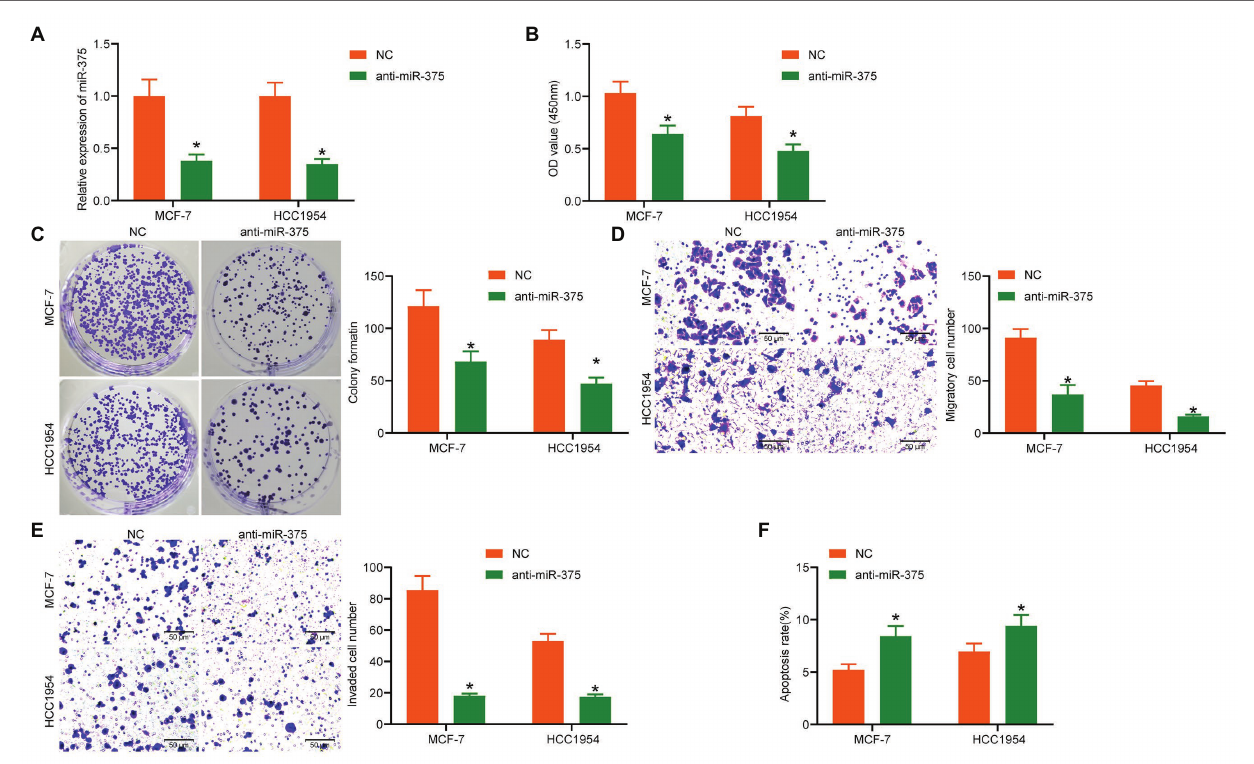
FIGURE 2 | Anti-miR-375 suppresses activity of BC cells. (A) Transfection efficacy of anti-miR-375 in MCF-7 and HCC1954 cells examined by RT-qPCR (* p < 0.05, two-way ANOVA); (B) viability of cells determined by the CCK-8 method (* p < 0.05, two-way ANOVA); (C) colony formation ability of cells determined by the colony formation assay (* p < 0.05, two-way ANOVA); (D,E) migration (D) and invasion (E) abilities of cells measured by the Transwell assays (* p < 0.05, two-way ANOVA); (F) apoptosis of cells determined by flow cytometry (* p < 0.05, two-way ANOVA). Data were presented as mean ± SD from three independent